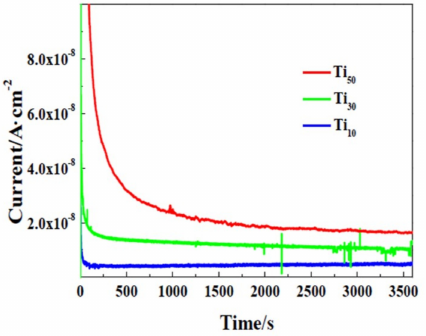
Figure 10. Chrono-amperometric curves of CP-Ti anodization under potentiodynamic-aging mode at 10, 30 and 50 V.